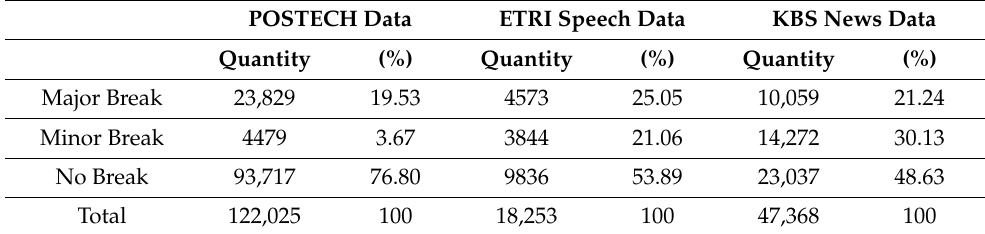
Table 1. Distribution of the three types of prosodic